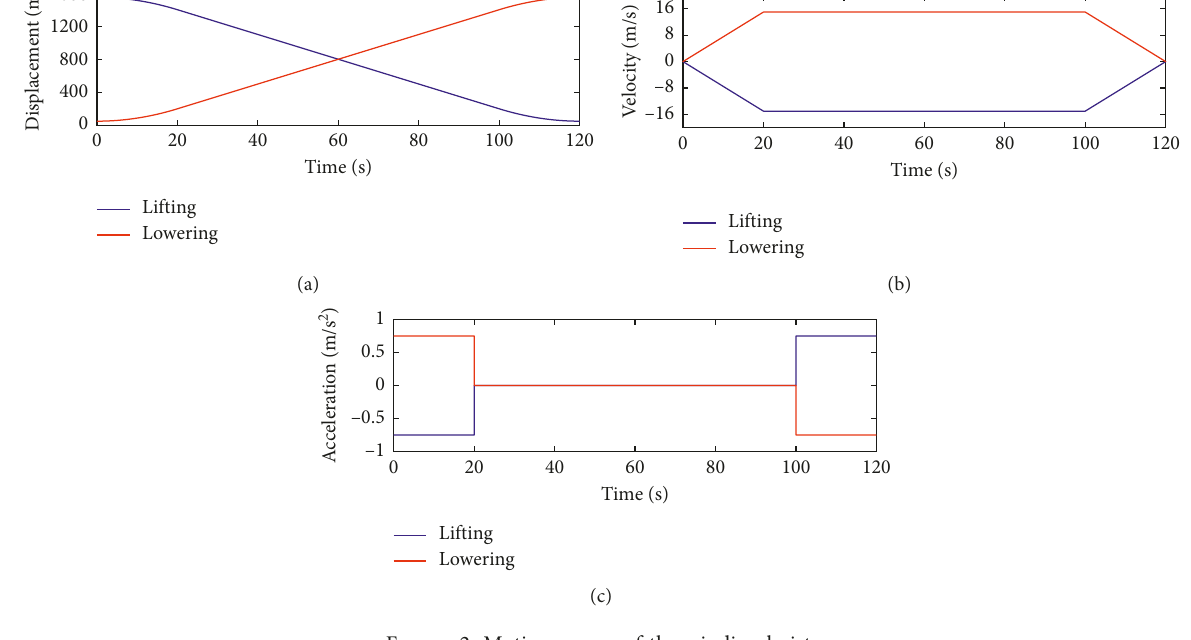
Figure 2: Motion curves of the winding hoist.